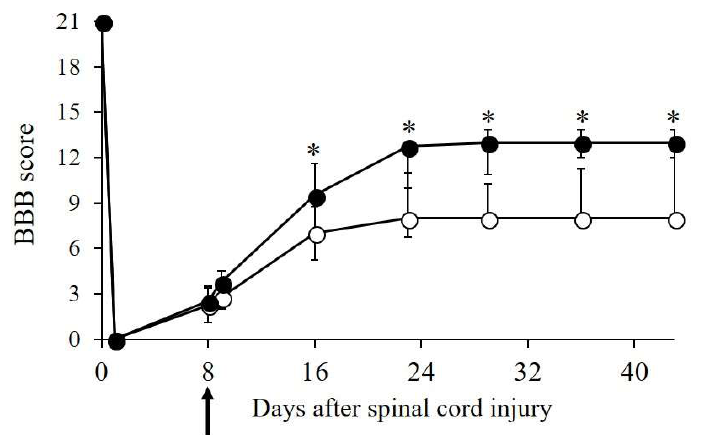
Figure 5. Functional recovery following ASC transplantation. On day eight after injury (arrow), 12-week-Cryo-ASCs (2.5 × 10 6 cells) were infused into spinal cord injury (SCI) rats via the tail vein ( n = 8). Basso–Beattie–Bresnahan (BBB) scores were determined before and after transplantation. Black and white circles are ASC and saline group, respectively. The median score is plotted; bars show the inter quartile range (IQR). * p < 0.05 vs. saline controls ( n = 10).